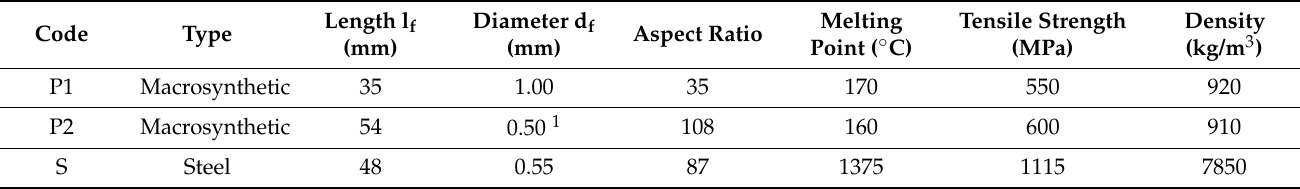
Table 2. Properties of the fibers used in the present study *.